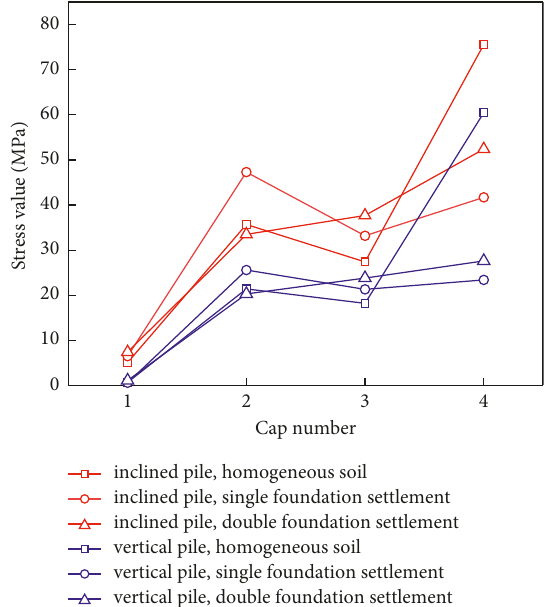
Figure 15: Maximum stress contrast diagram of